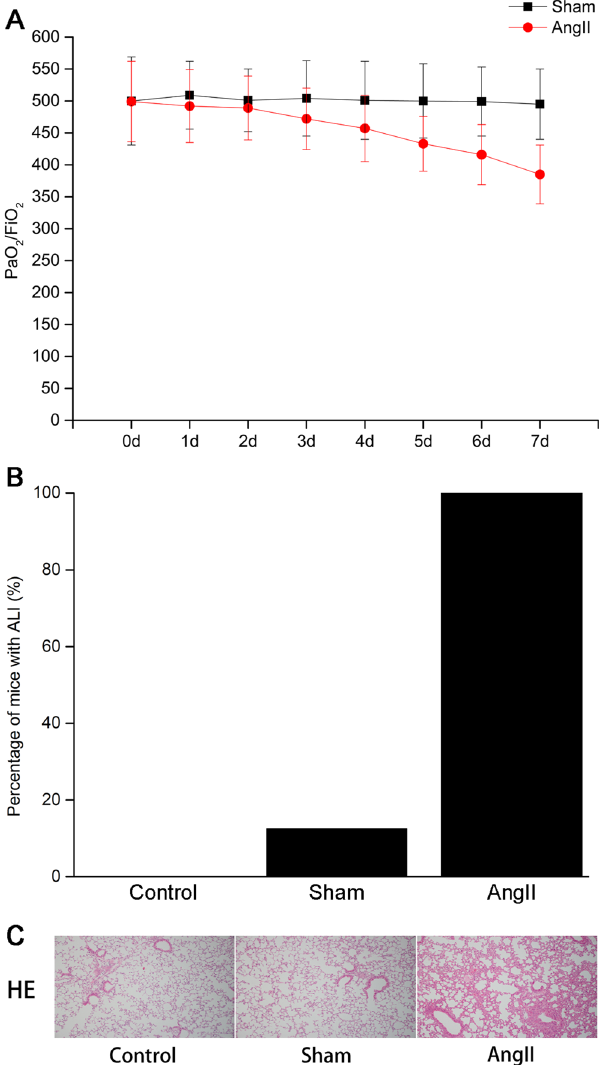
Figure 1. Establishing of mice ALI model through subcutaneous infusion of AngII. ( A ) Blood gas results. ( B ) Comparison of ALI incidence among groups. ( C ) HE staining of the lung tissues in mice. Obvious lung oedema and inflammatory cell infiltration were noticed in the lung tissues in AngII group. The images were observed under a magnification of 100 × .